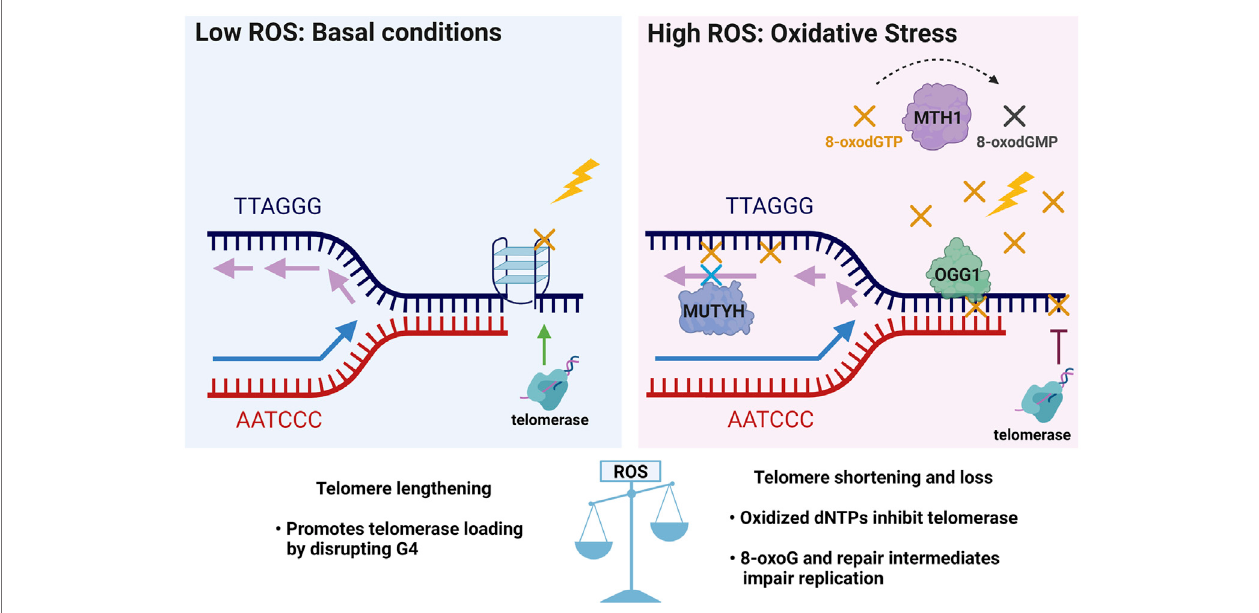
FIGURE 5 | Telomere 8-oxoG hormesis model and the crucial roles of the GO system enzymes in telomere stability. In unstressed conditions of basal ROS, low levels of 8-oxoG (yellow X) may promote telomere maintenance by destabilizing G4s structures (as shown in Figure 4 ) which block telomerase loading and impair replication, and may thereby facilitate telomere lengthening. Conversely, elevated ROS under oxidative stress inhibits telomere maintenance by producing excess 8- oxoG lesions (yellow X) and repair intermediates that impair telomere replication, and by producing 8-oxodGTP (yellow X) which inhibits telomerase. Thus, under oxidative stress the GO system may play a critical role in telomere preservation through MTH1 hydrolysis and removal of 8-oxodGTP, OGG1 initiated BER of 8-oxoG opposite C, and MUTYH initiated BER removal of A misinserted opposite 8-oxoG in the template strand. Thus, a little telomeric 8-oxoG may be bene fi cial for telomere maintenance, but too much telomeric 8-oxoG is detrimental for telomere